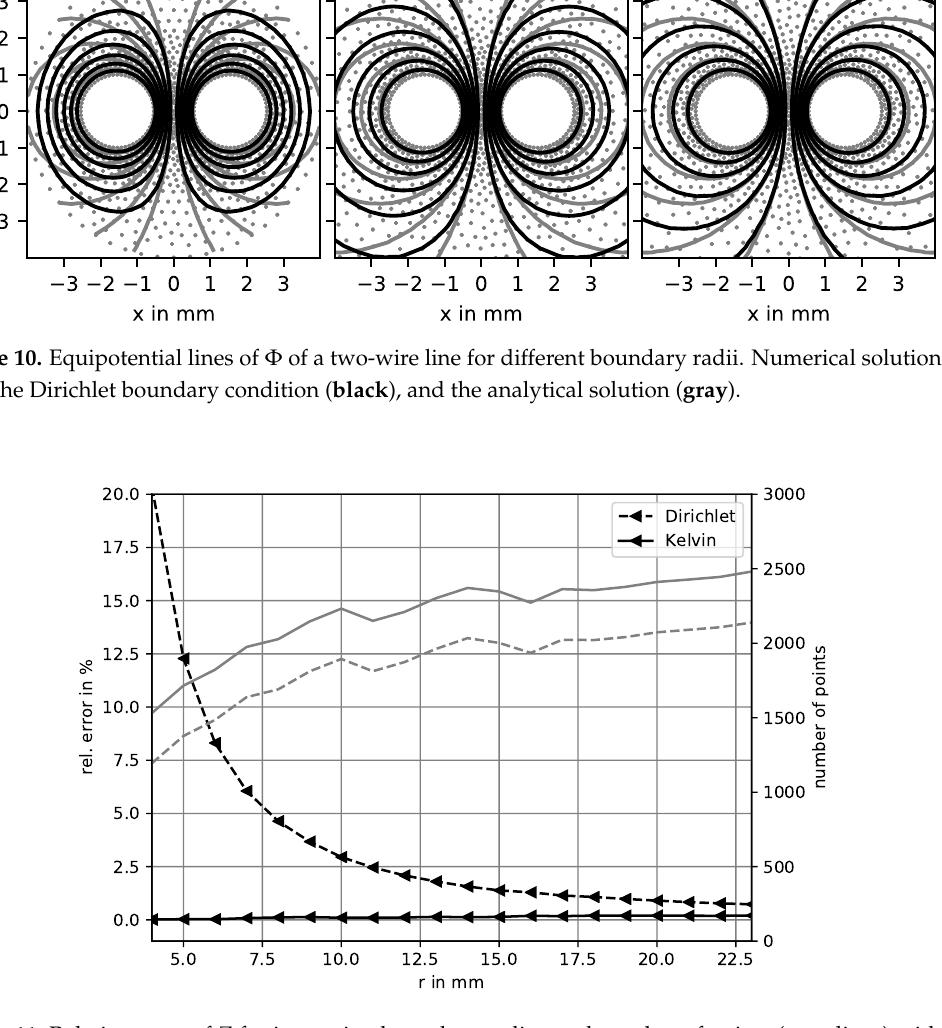
Figure 11. Relative error of Z for increasing boundary radius and number of points (gray lines) with and without outer